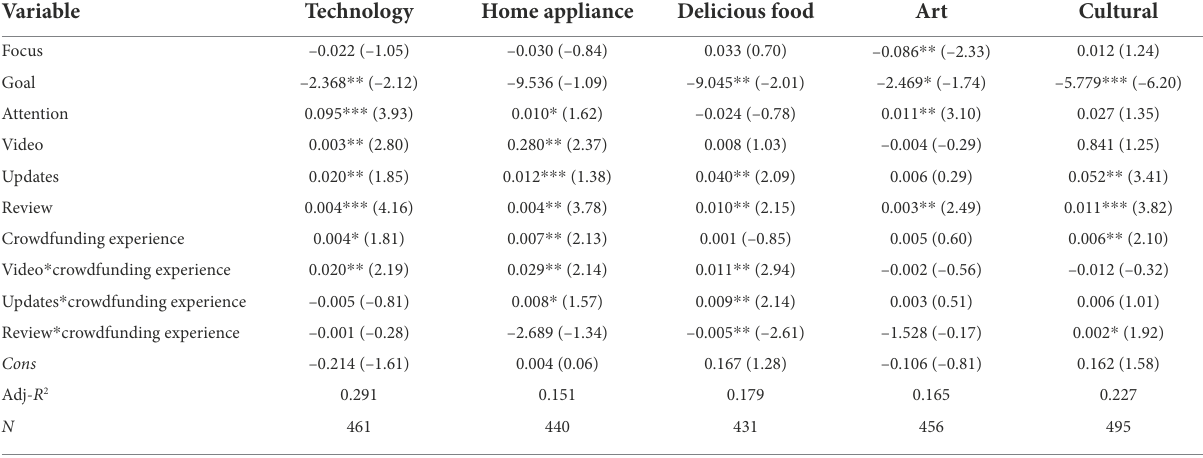
TABLE 4 Regression analysis of the effect of differences in project types on